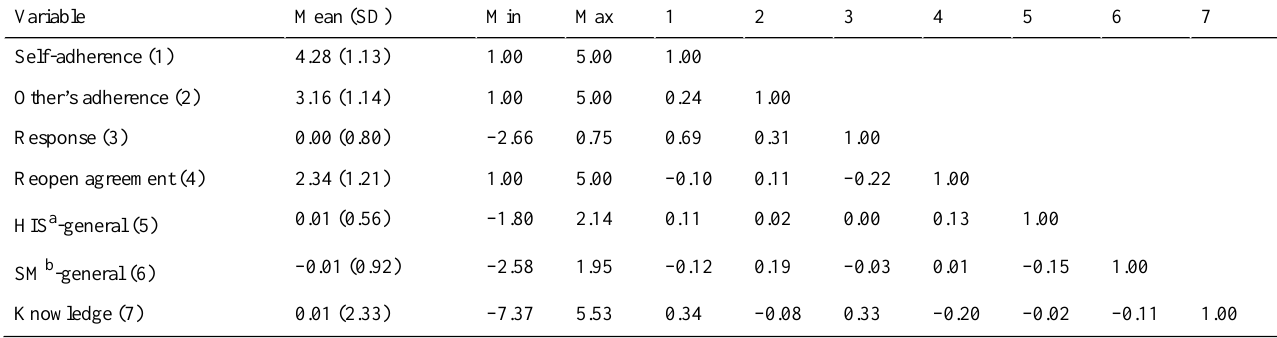
Table 1. Summary statistics and pairwise correlations among key variables (N=482). 7654321MaxMinMean